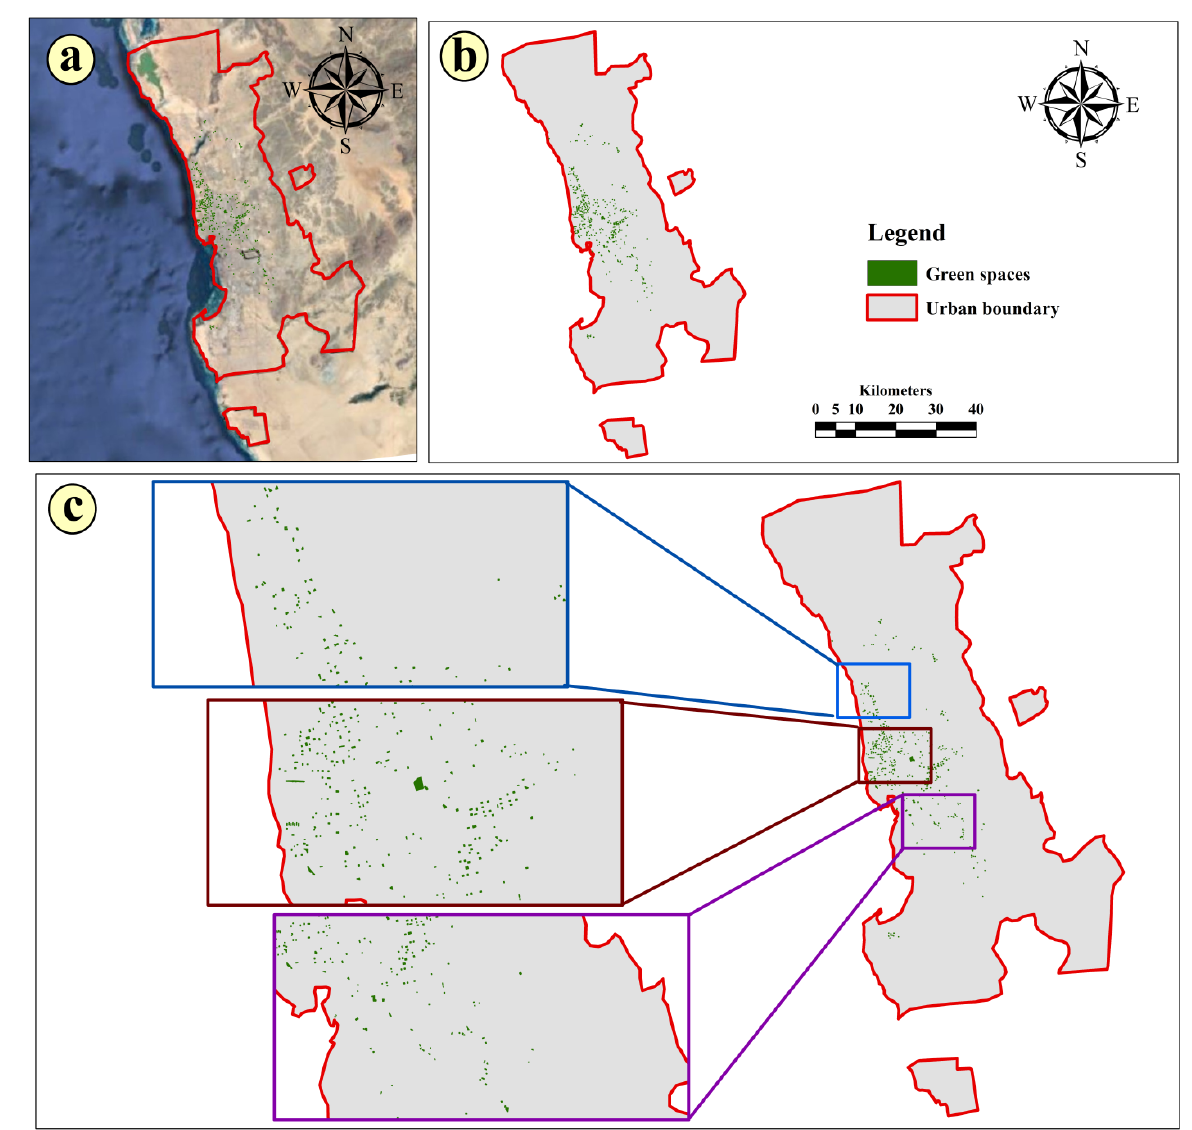
Figure 3. Spatial distributions of GSs in Jeddah City ( a ); Jeddah satellite image with the GSs; ( b ) GSs distribution in Jeddah in regard to the city urban growth boundary and; ( c ) detailed view to the GSs in the